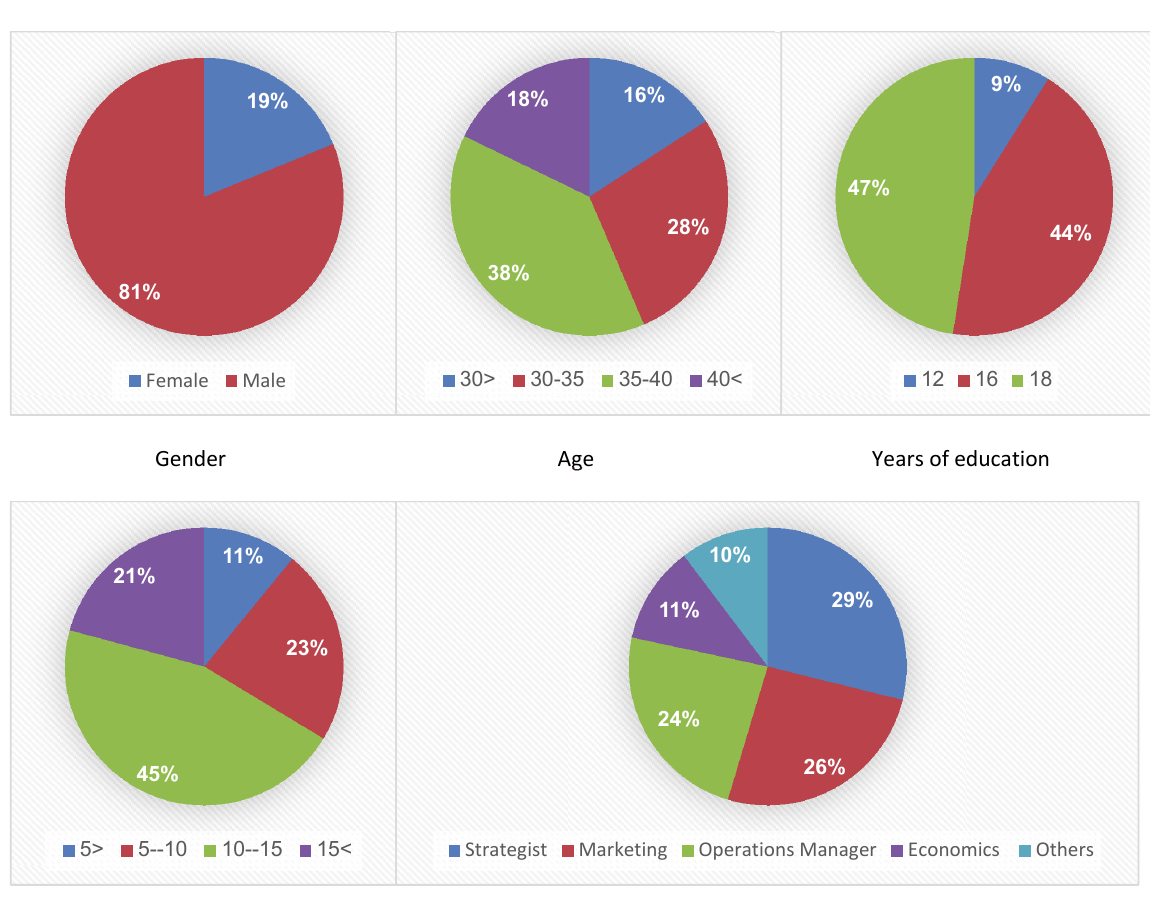
Fig. 2. Personal characteristics of the